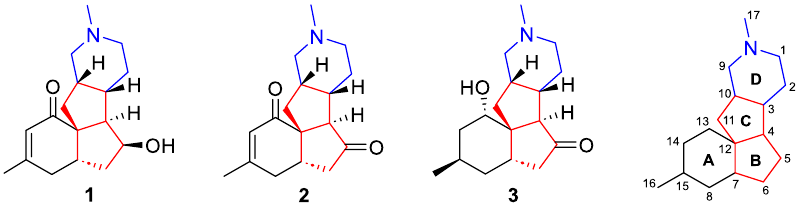
Figure 2. Structures of (–)-magellanine ( 1 ), (+)-magellaninone ( 2 ), and (+)-paniculatine ( 3 ), and carbon numbering of the core.